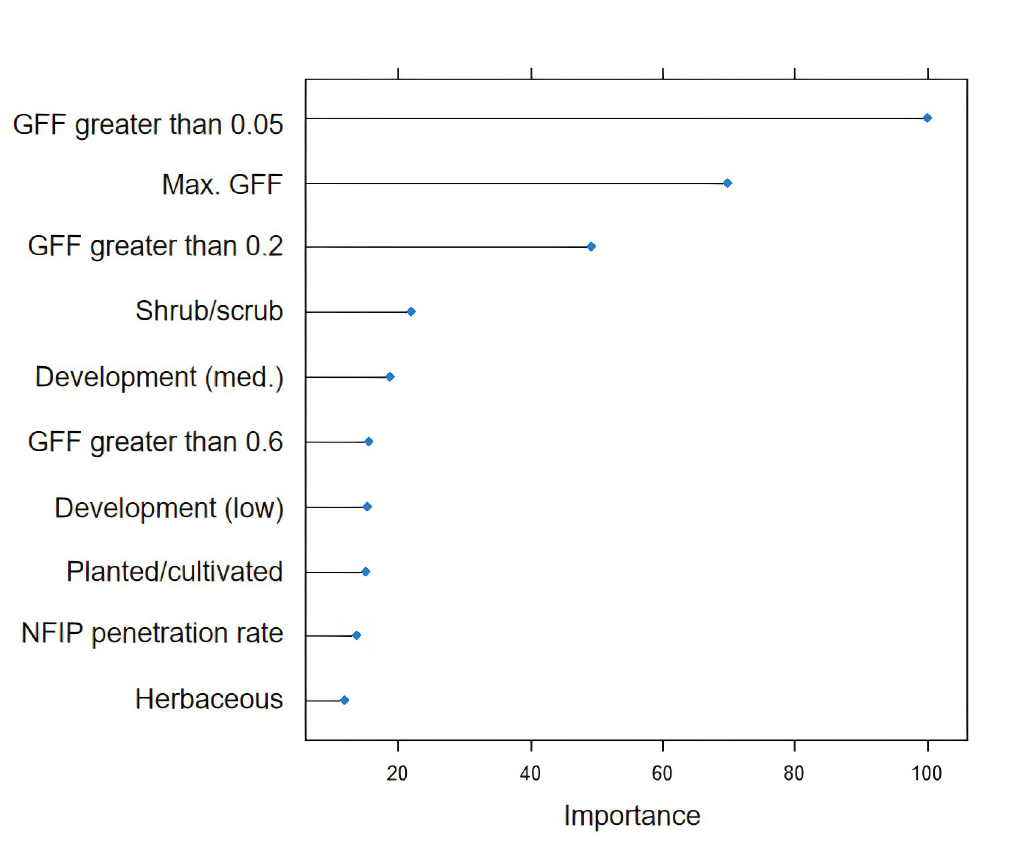
Fig 3. Variable importance plot for the GFF model. See S1 Table for a description of